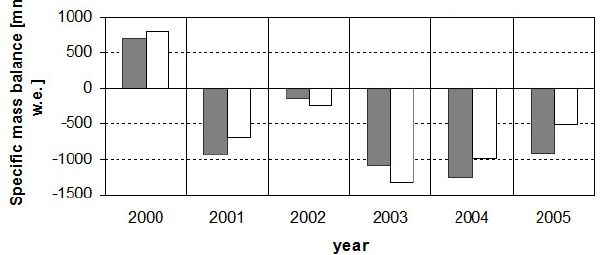
Fig. 4. Comparison of calculated mass balances. The grey (mod- elled, this study) and white (measured, Strelin and Iturraspe (2007), 2000–2003; WGMS (2005), 2004–2005) columns show the mass balance of Martial Este Glacier.